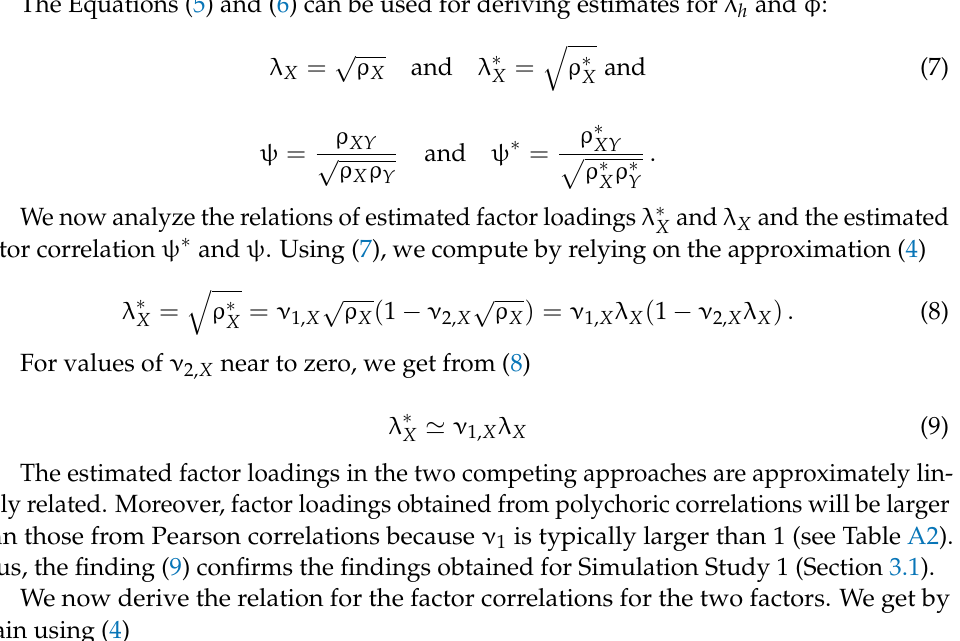
Figure 2. Relation of the square root of the polychoric correlation (i.e., √ ρ ) and its linear and quadratic approximation for two items with extreme Pearson correlation (i.e., asymmetry and three categories (i.e., distribution type